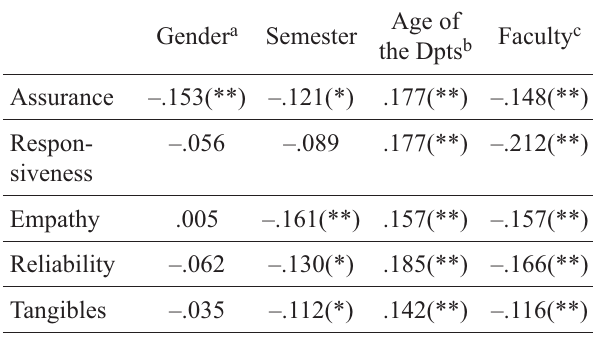
Table 7. Correlations between SERVQUAL dimensions and demographics/educational characteristics